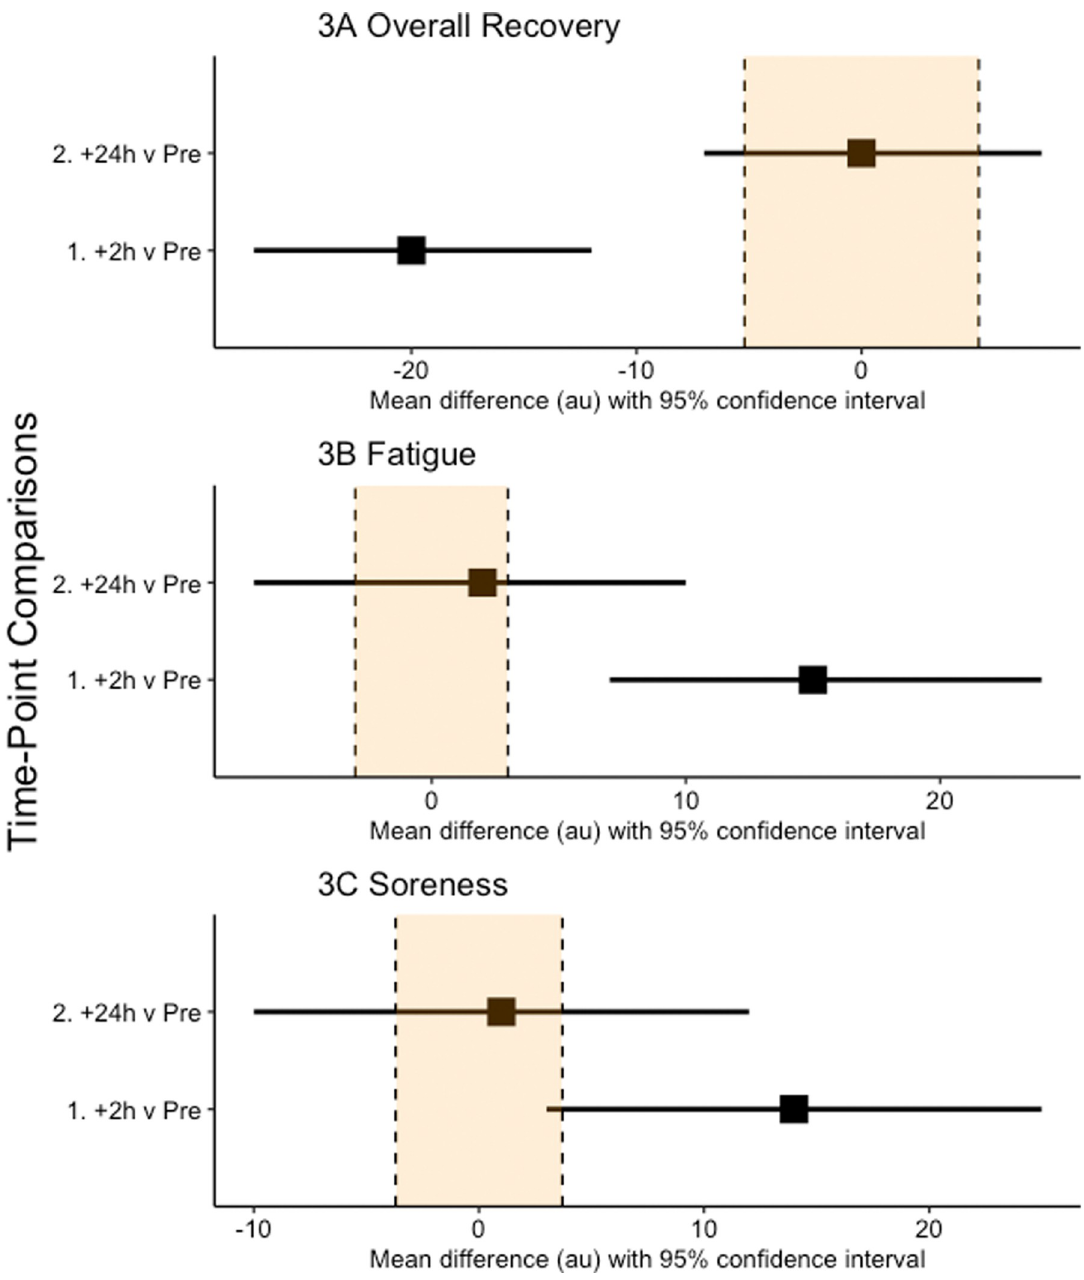
Fig 3. Effect statistics (mean difference and 95% confidence intervals) for the comparison of overall recovery (A), fatigue (B) and soreness (C) immediately (+0h), two (+2h) and 24 (+24h) hours following the performance of the training session compared to baseline. Zero (0) on the axis represents no difference between that time-point and